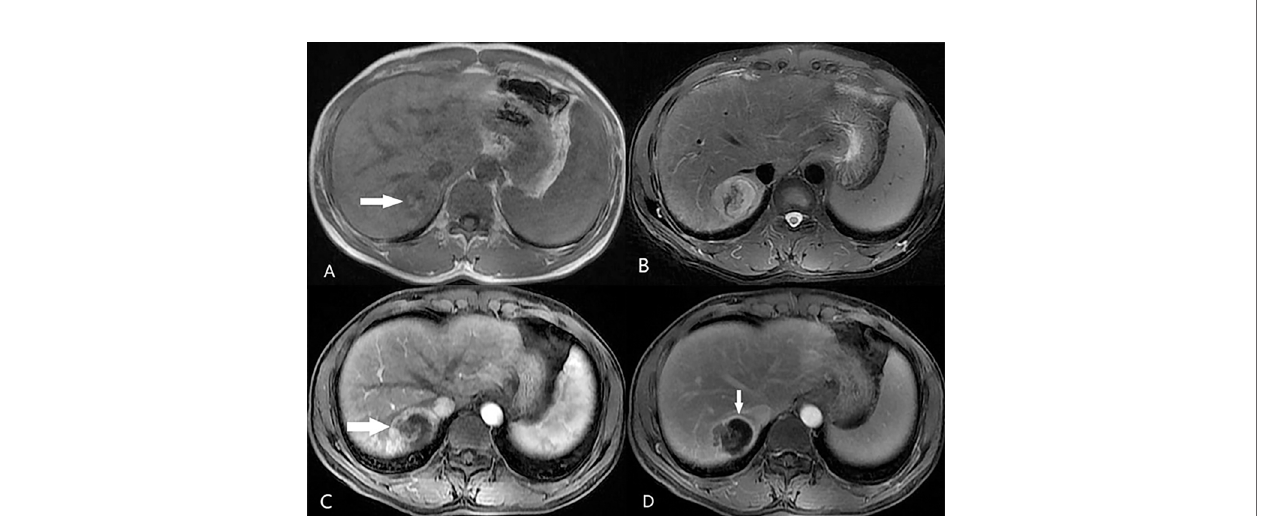
FIGURE 3 | A 48-year-old male patient with hepatitis B-related liver cirrhosis and HCC is categorized as LR-M category. (A) T1-weighted image shows a 36-mm nodule with blood product in mass (arrow) in hepatic segment VIII. The nodule shows heterogeneous hyperintensity on (B) T2-weighted image. (C) The arterial phase shows peripheral enhancement (arrow) on contrast-enhanced T1-weighted imaging with the contrast agent Gd-DTPA, and (D) the delay phase shows incompletely enhancing capsule (arrows).